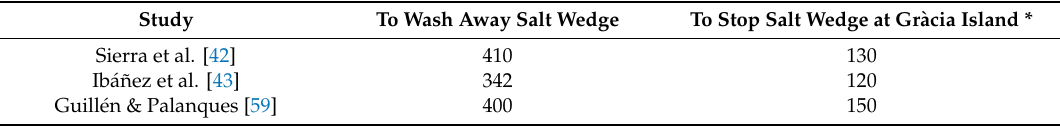
Table 3. Minimum river flows (m 3 / s) required for the control of the salt wedge in the Ebro estuary, according to di ff erent